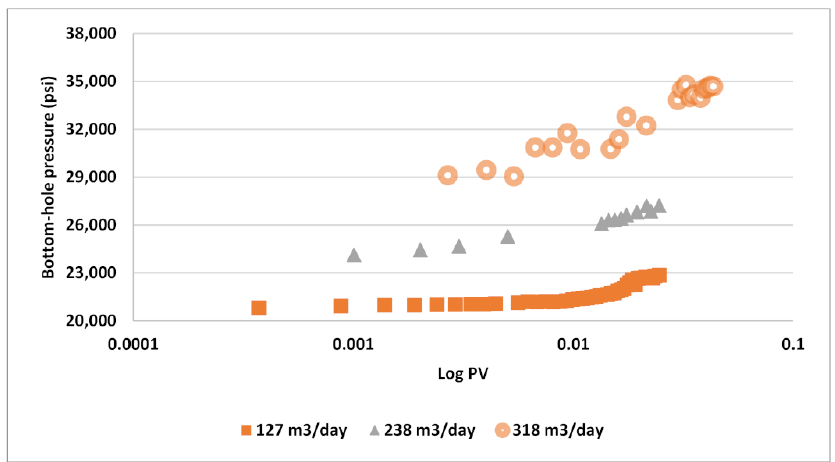
Figure 19. BHP versus log pore-volume at different injection